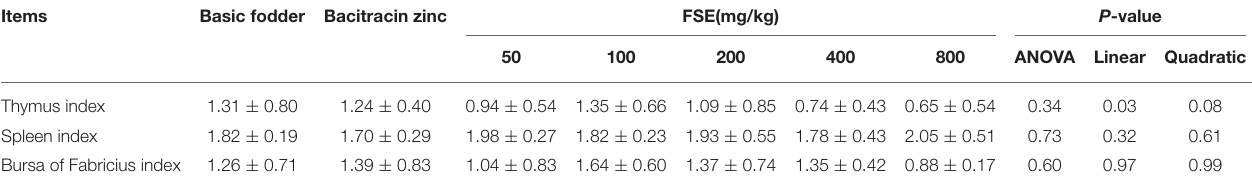
TABLE 5 | Effect of fenugreek seed extract on immune organ index of broilers (%) 1 .